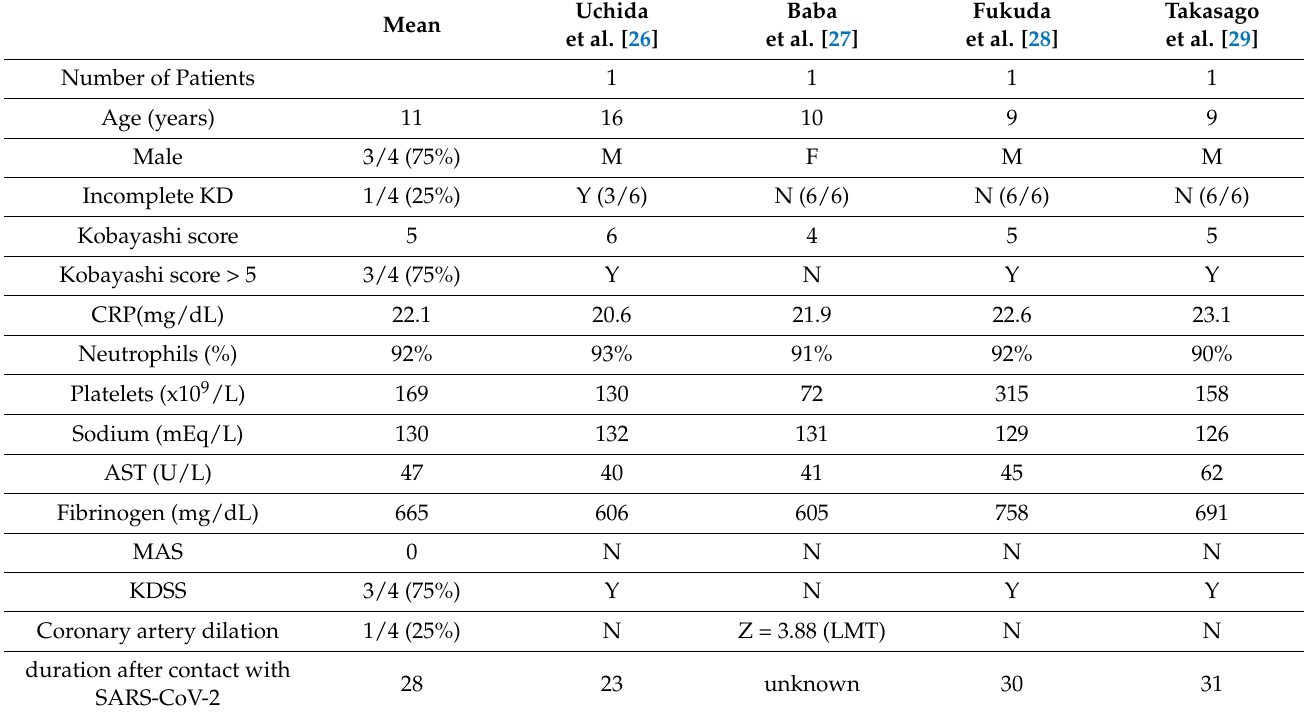
Table 4. Comparison with Japanese reported cases of MIS-C or